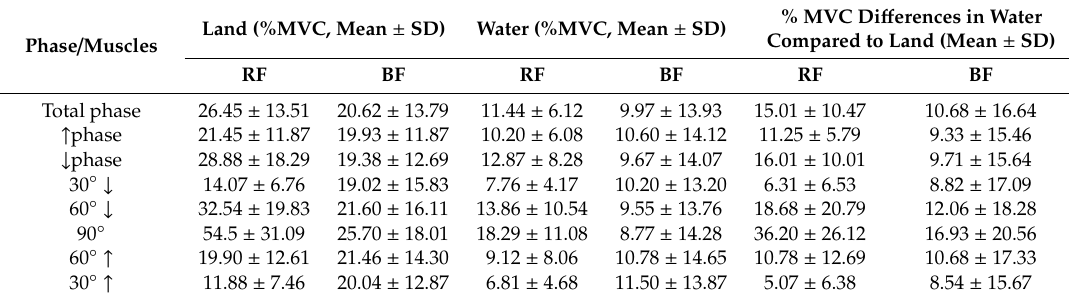
Table 2. Mean, standard deviation and the percentage di ff erence (as compared to land) of %MVC of RF and BF muscles at di ff erent phases in water compared to land.